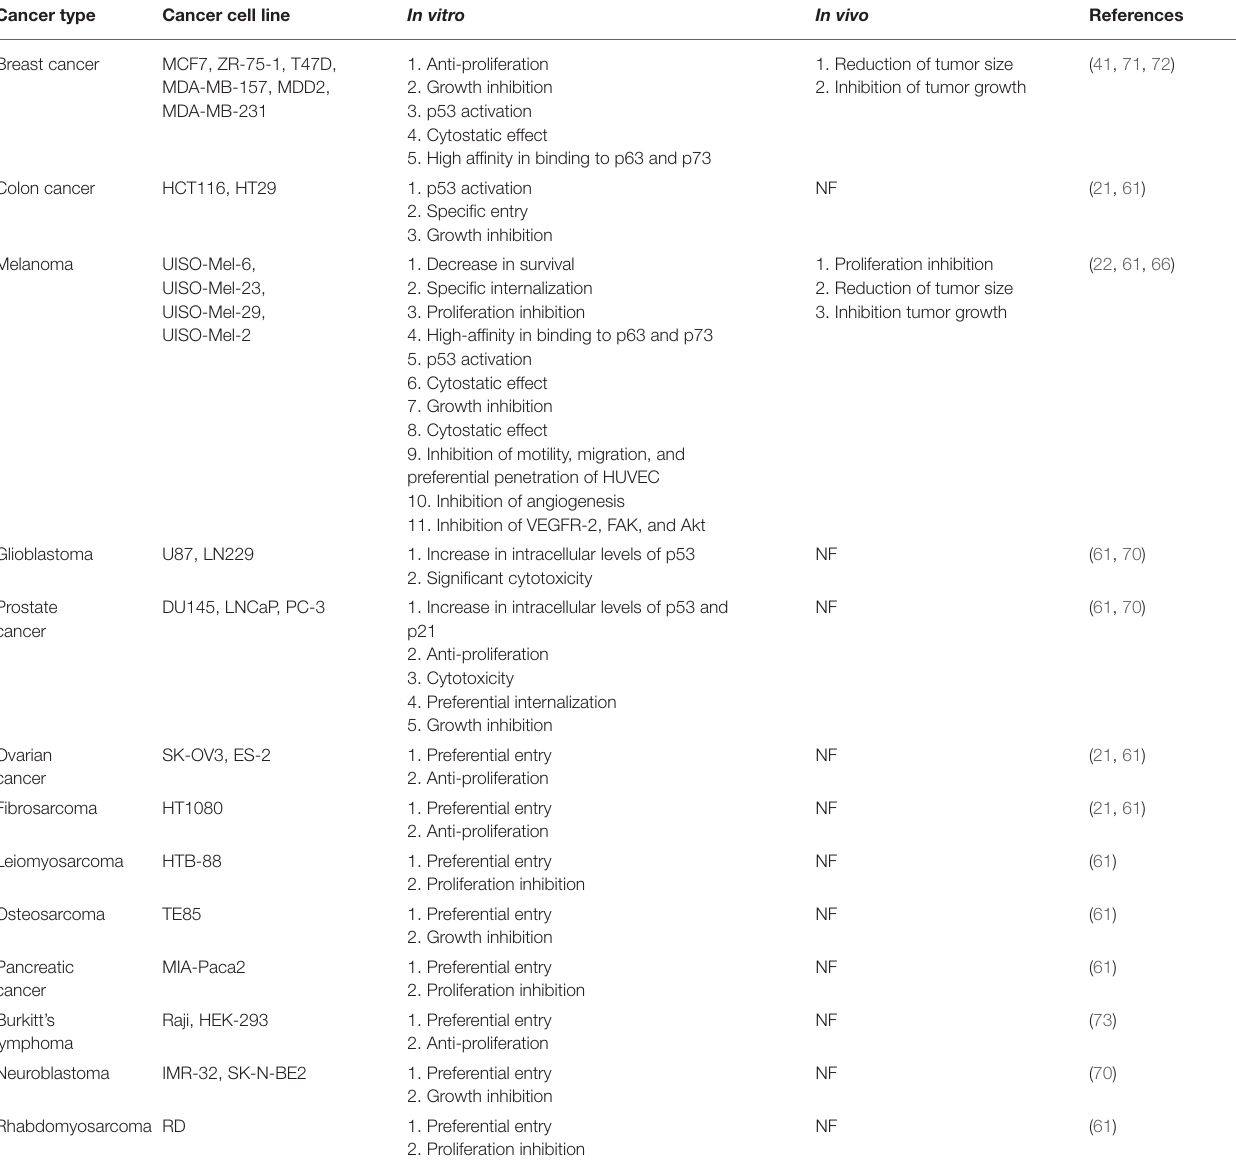
TABLE 2 | Anticancer effect of azurin-p28 on different cancer cells with in vitro and in vivo . Cancer